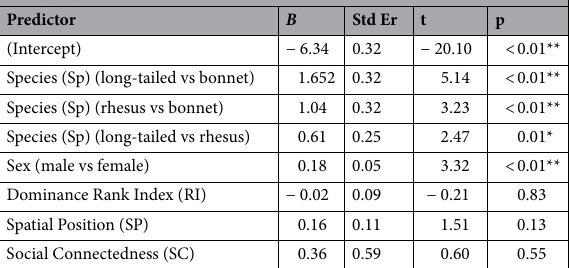
Table 2. Best-fit GLMM examining the impact of macaque attributes on the diversity (D) of human–macaque interactions. Group (G) was a random effect, and observation time (OT) was an offset variable. **p < 0.01.